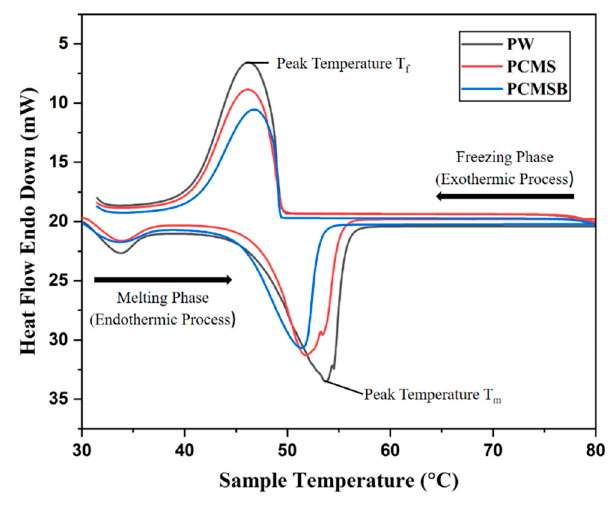
Figure 5 . DSC curves of the paraffin wax/steatite composite . Figure 5. DSC curves of the paraffin wax/steatite composite.